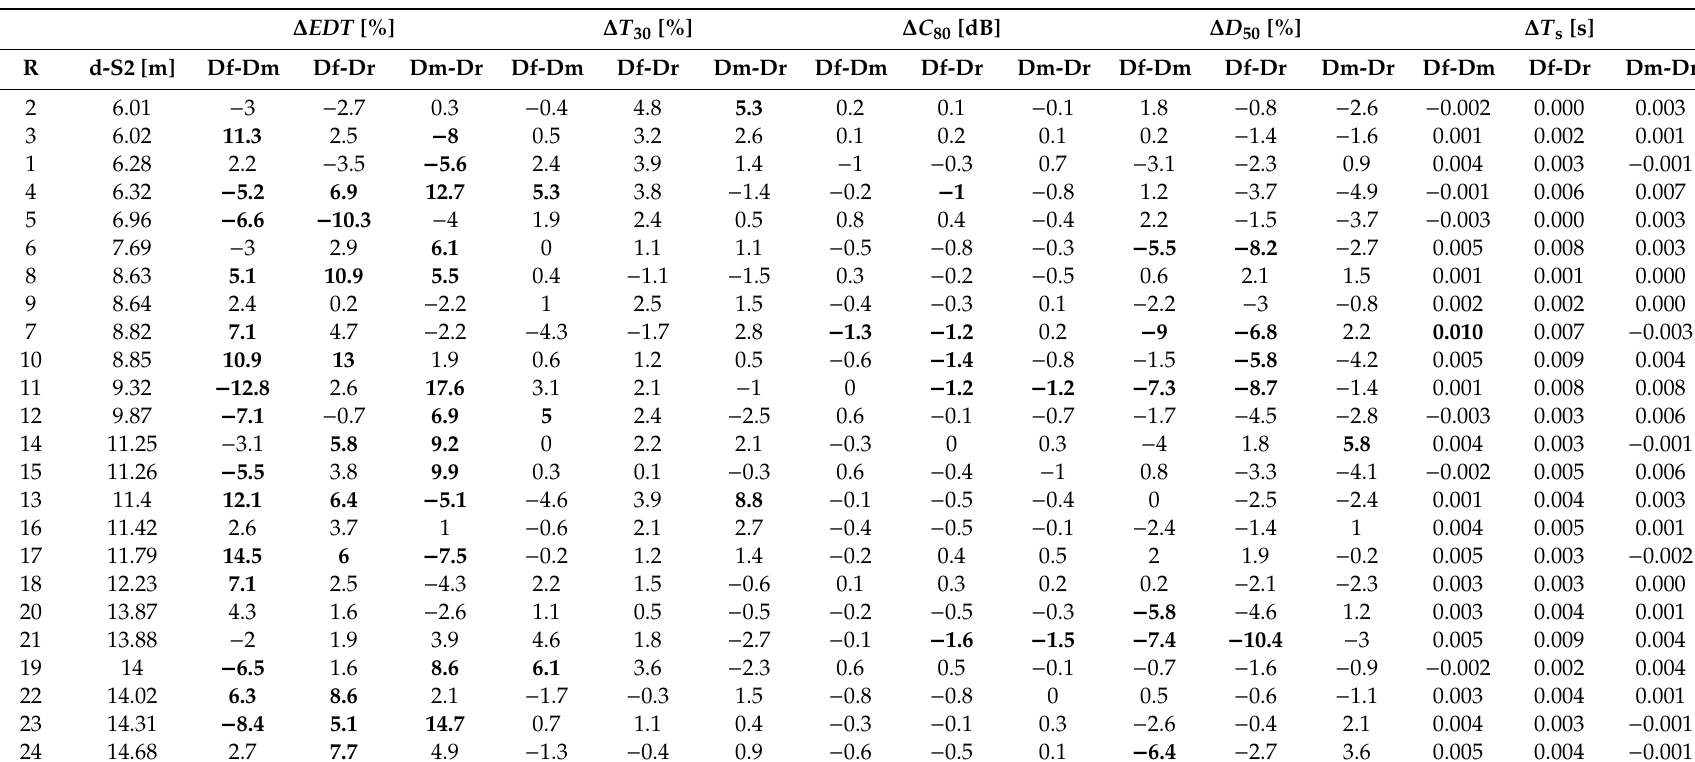
Table A4. Objective acoustic parameter di ff erences between the configurations with di ff erent di ff user locations in the absorptive (-A) condition for